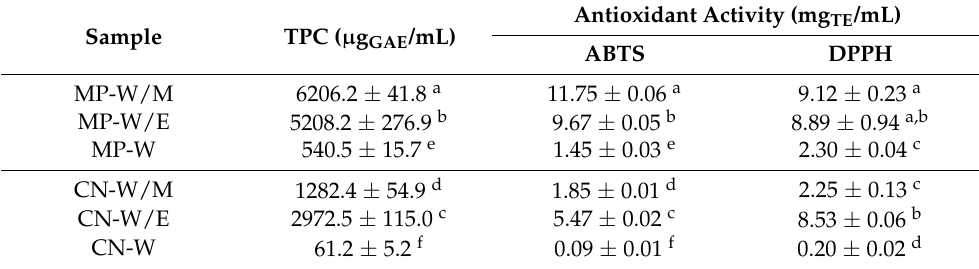
Table 5. Total phenolic content and antioxidant activity of Mentha piperita L. and Urtica dioica L. leaf extracts. The results are expressed as mean ±